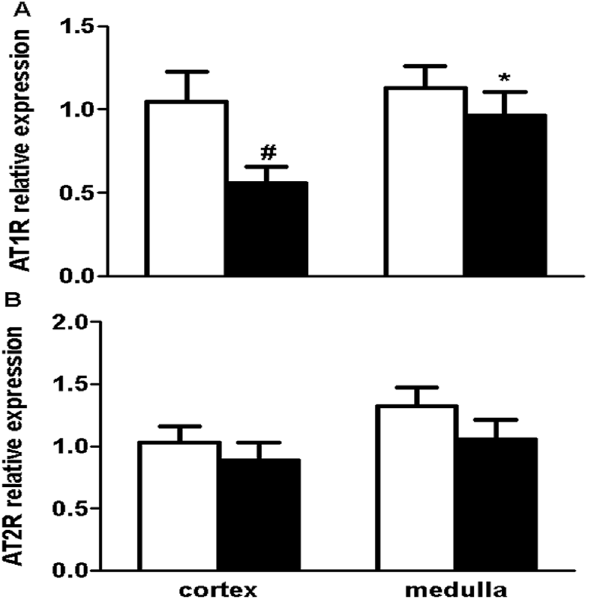
Figure 4. Angiotensin II receptor gene expression in the kidney cortex and medulla of 5 year old female sheep (A) Angiotensin II receptor type 1 (AT1R), (B) Angiotensin II receptor type 2 (AT2R). Sham (white bars, N=5) and uni-x (black bars, N=5) Values are mean 6 SEM. # P , 0.05 comparing sham and uni-x animals and *P , 0.05 comparing kidney zones within the sham or uni-x group from Bonferroni post-hoc test.